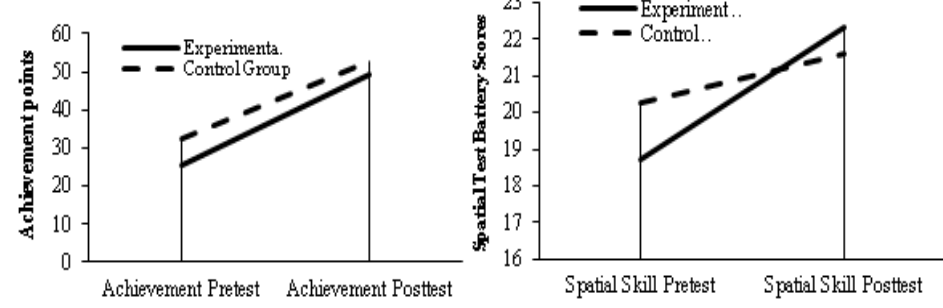
Figure 1. Pre-test and post-test scores of students in the experimental and control groups Findings for the Qualitative Part of the